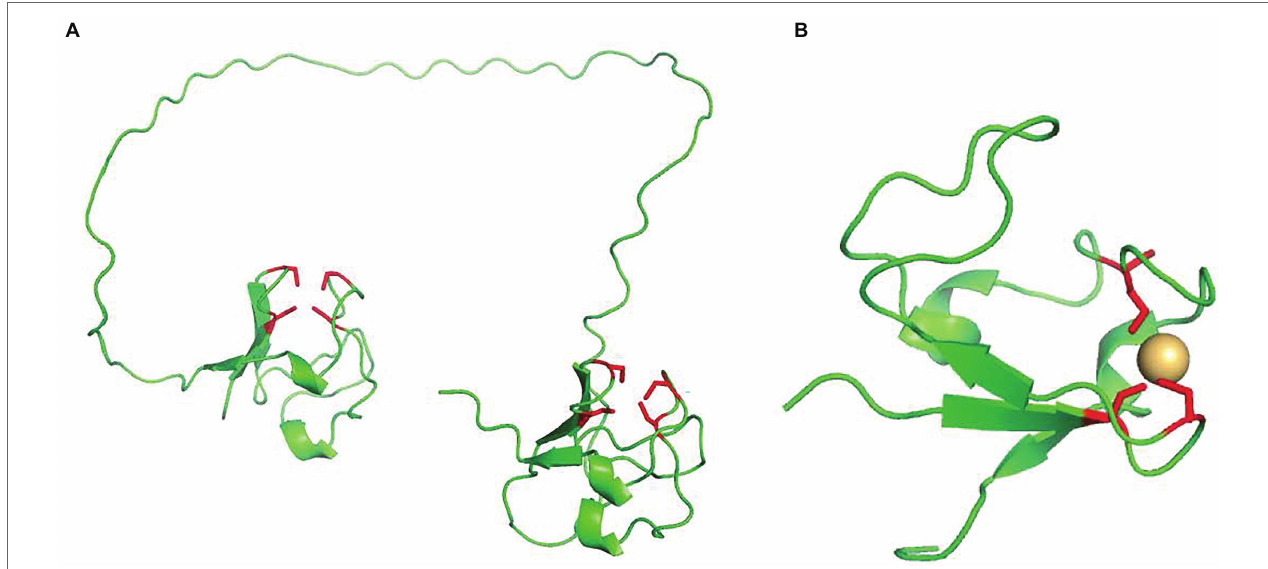
FIGURE 1 | (A) The AlphaFold predicted structure of AlkG from P. putida GPo1. The cysteines that form the iron–sulfur clusters are colored in red. (B) The structure of the single domain rubredoxin from Pseudomonas aeruginosa , Again, the cysteines that form the iron–sulfur clusters are colored in